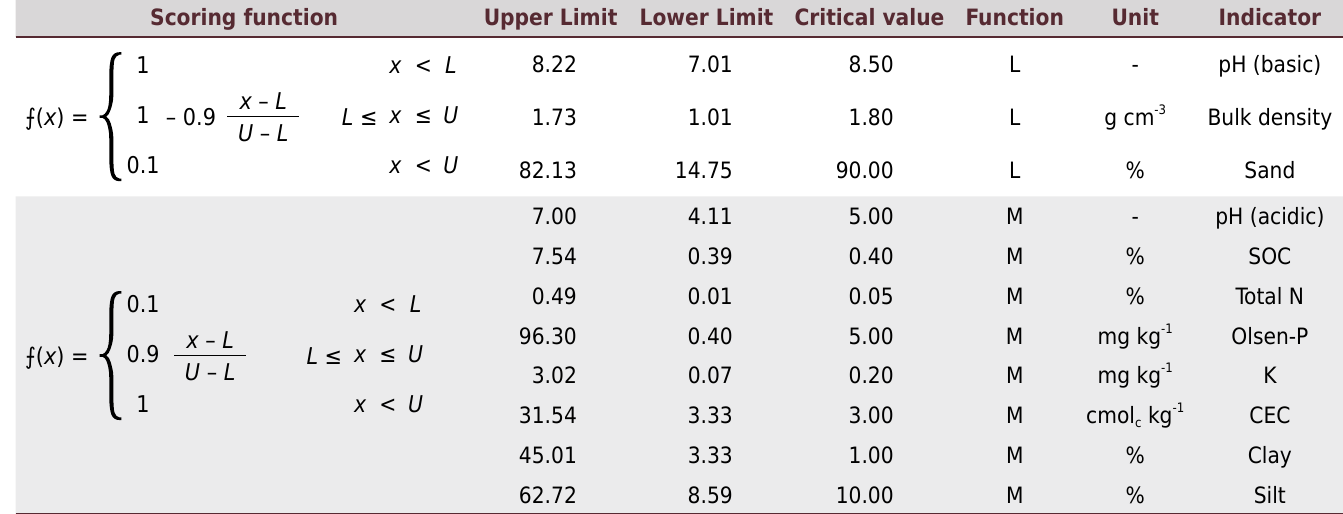
Table 3. Standard scoring functions (SSFs) and parameters for soil sites (n = 194) Scoring